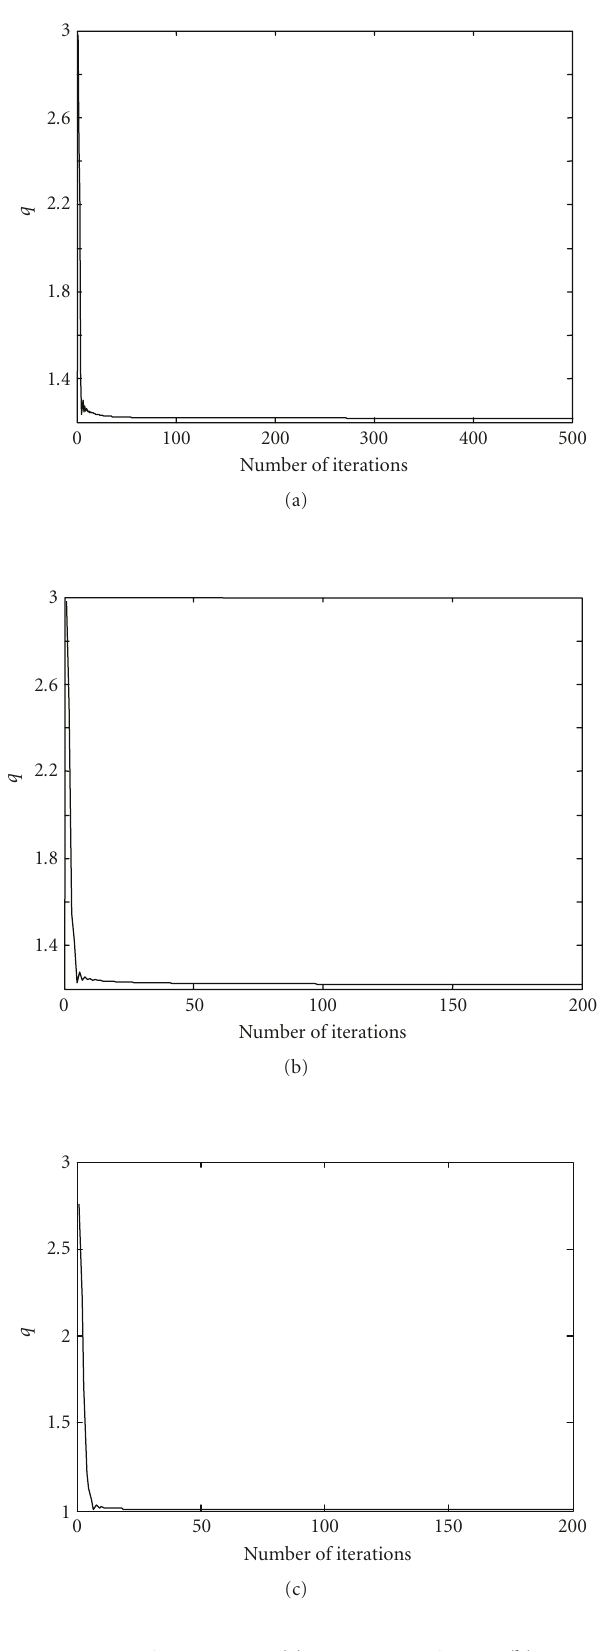
Figure 7: Iteration versus q (a) Cameraman image, (b) Lenna image, and (c) Anuska image.